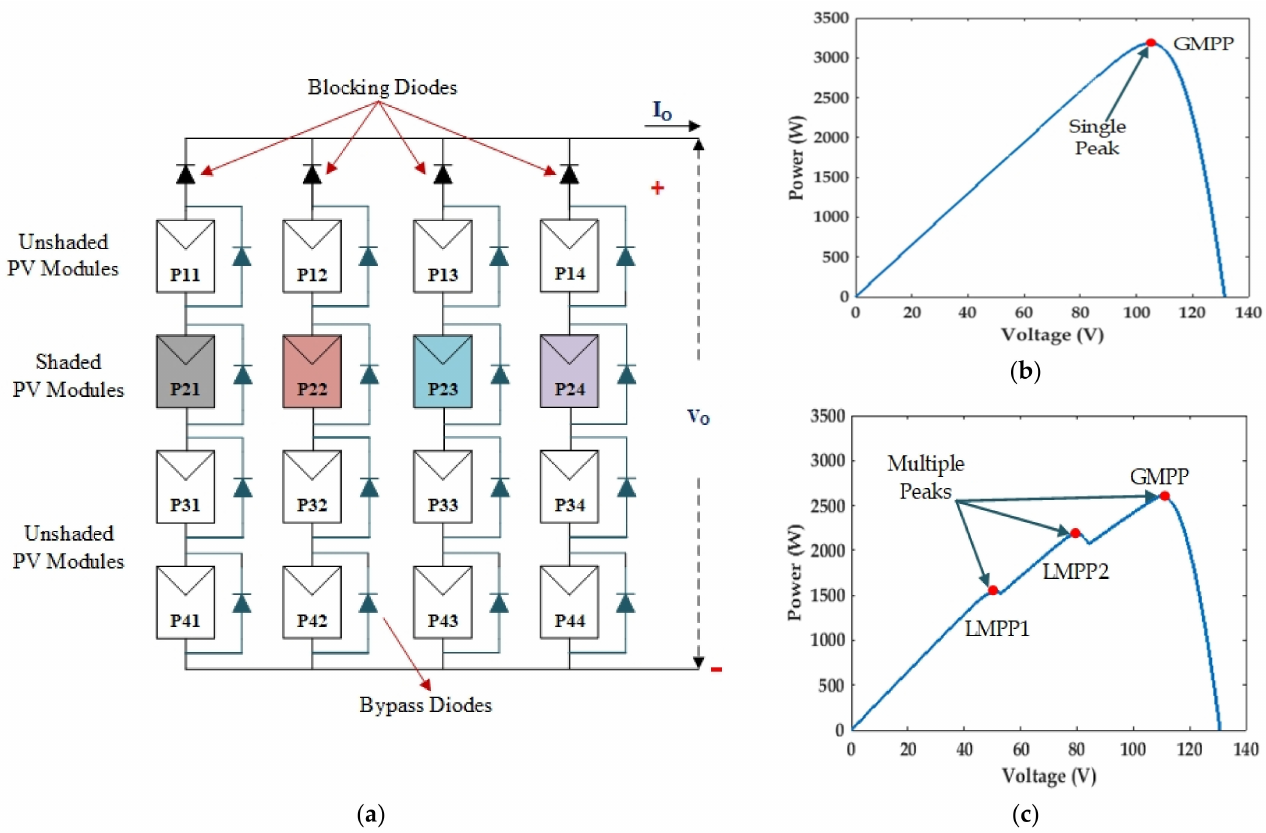
Figure 4. ( a ) Shaded SP PV array; ( b ) PV curve for uniform irradiation; ( c ) PV curve for nonuniform